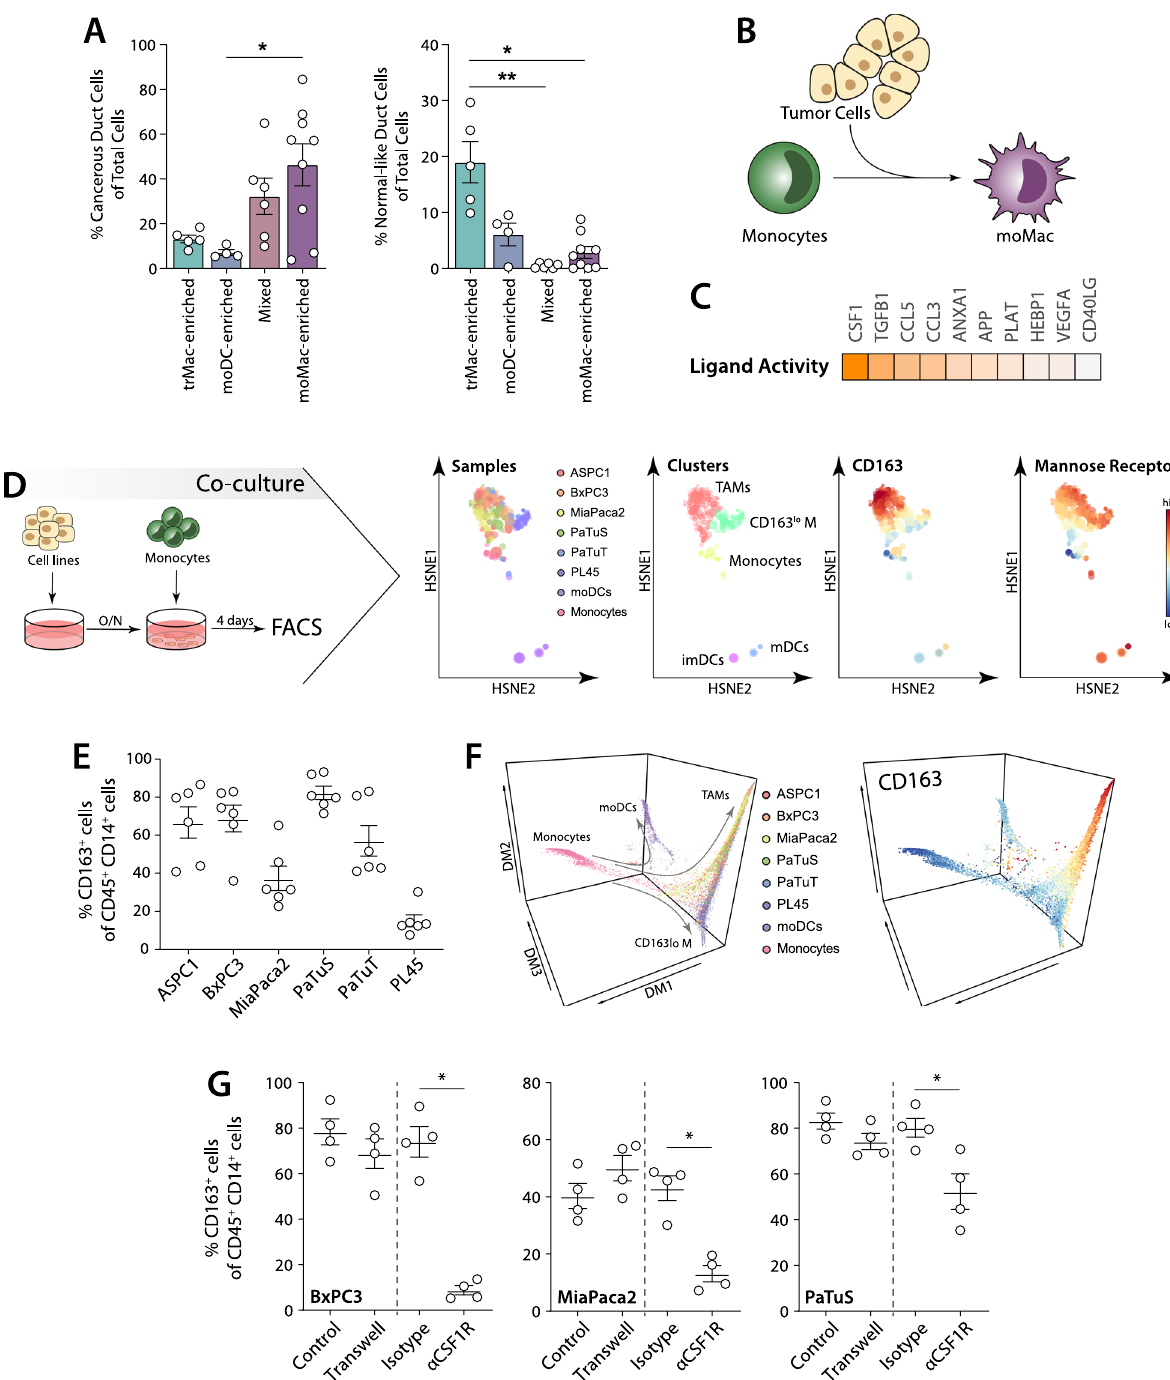
Fig. 4 Characterisation of the myeloid cells in PDAC. A moMac-enriched patients contain a higher content of cancer cells in scRNA-seq data from Peng et al. Patients numbers: trMac-enriched ( n = 5), moDCs-enriched ( n = 4), mixed ( n = 6), moMac-enriched ( n = 9). Data presented as mean values ± SEM. Statistics: Kruskal-Wallis test with Dunn ’ s multiple comparisons test. B Proposed model for tumour cell-mediated monocyte to macrophage differentiation in PDAC. C NicheNet algorithm predicts M-CSF (CSF1) as tumour-derived factor that in fl uences moMac differentiation. D Co-culture of PDAC cell lines with monocytes induces their differentiation to macrophages. E Quanti fi cation of CD163 positive cells after co-culture indicated in ( D ). Data presented as mean values ± SEM. F Analysis of monocyte differentiation using diffusion maps (using the R package destiny ). Three-dimensional graph showing the inferred differentiation pathways and the expression of CD163. G Differentiation of monocytes to CD163 + macrophages in co-cultures of monocytes and cancer cell lines in a transwell model and in the presence of a blocking antibody to CSF1R. Data presented as mean values ± SEM. Statistics: Friedman test (* p < 0.05).